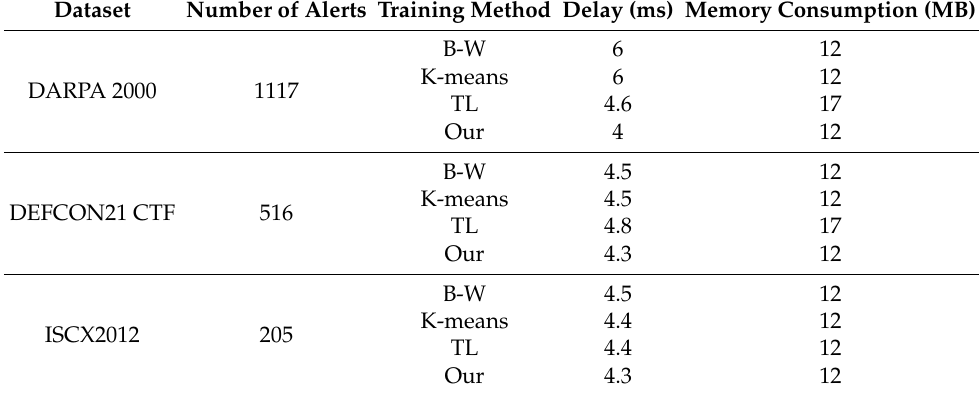
Table 3. Online detection delay and the number of